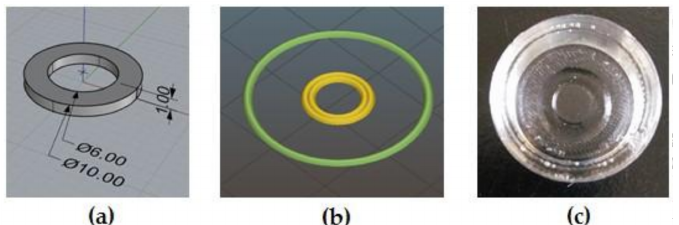
Figure 1. Printing process of the ring-shaped hydrogels in the polydimethylsiloxane (PDMS) support. ( a ) CAD model obtained using Rhinoceros software; ( b ) preparation of .gcode file; the control perimeter produced by Slic3r is shown in green; ( c ) Methylcellulose (MC)-based hydrogel printed in the PDMS